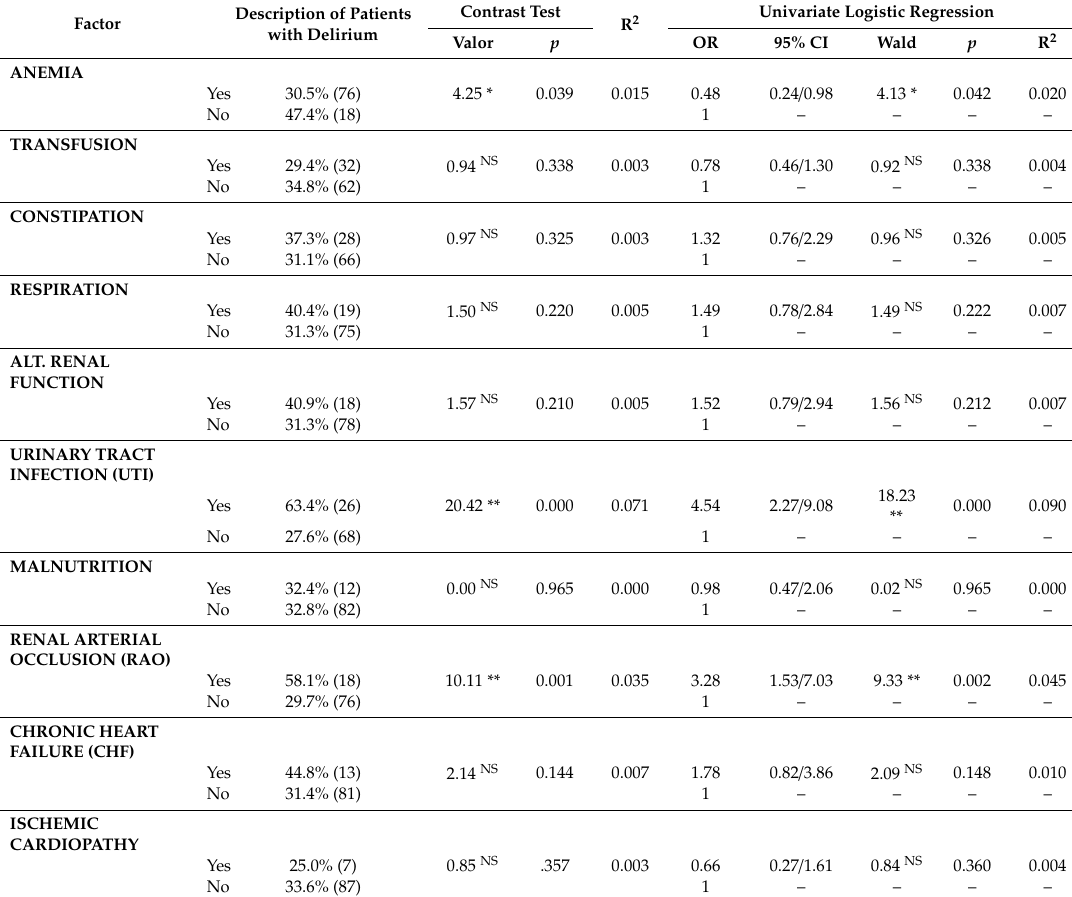
Table 3. Test of independence and univariate logistic regression. E ff ect of complication factors on the presence of delirium in octogenarian women with a hip fracture.